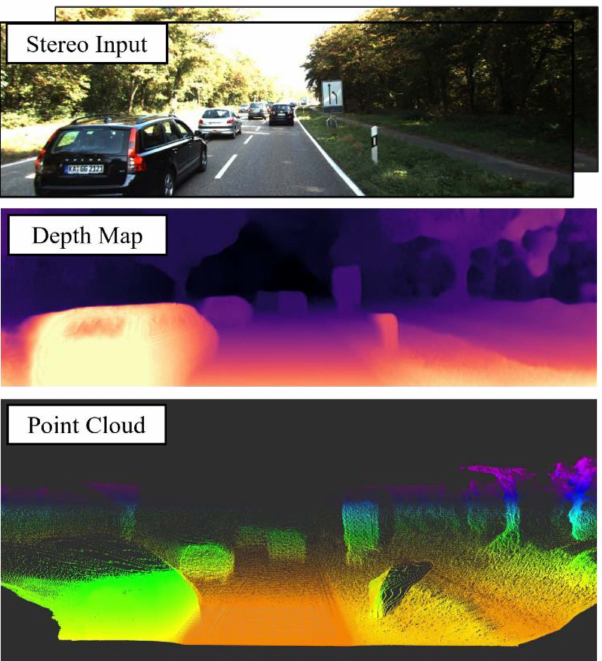
Figure 1. Point cloud generation from the depth map. ( Top image ): input to the pipeline-rectified stereo images from KITTI [4]; ( middle image ): estimated depth map using U-Net-based depth network; ( bottom image ): pseudo point cloud generation from the